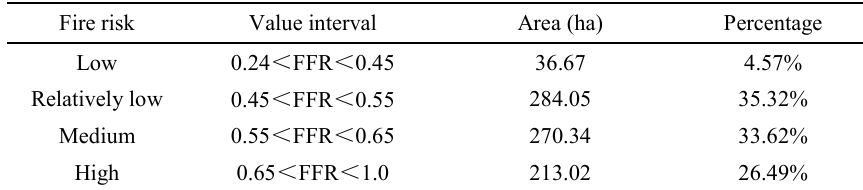
Table 5. WUI fire risk zoning scale and area of fire risk